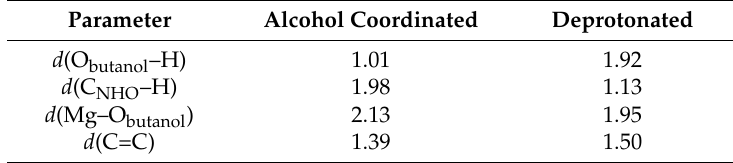
Table 8. Relevant interatomic distances changing during the proton transfer step. All values in